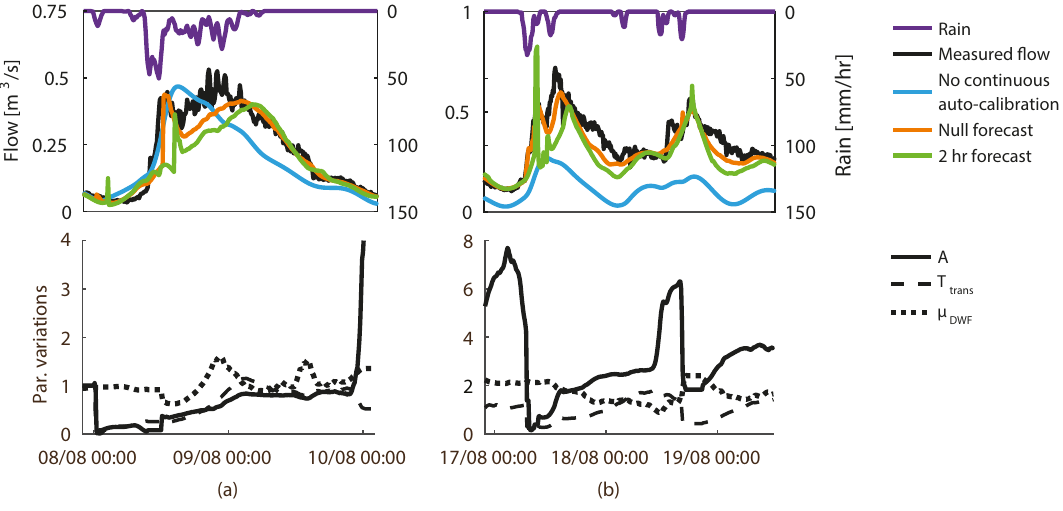
Figure 8. Example of two rain events modelled with the σ 0.5 · Extreme -scenario and an auto-calibration period of 12 h. ( Upper ) Measured flow together with the null forecast and the 2 h forecast. ( Lower ) Variations of parameters relative to their estimated mean values (cf. Table 1). ( a ) Rain event from 8 to 10 August ( b ) Rain event from 17 to 19 August.